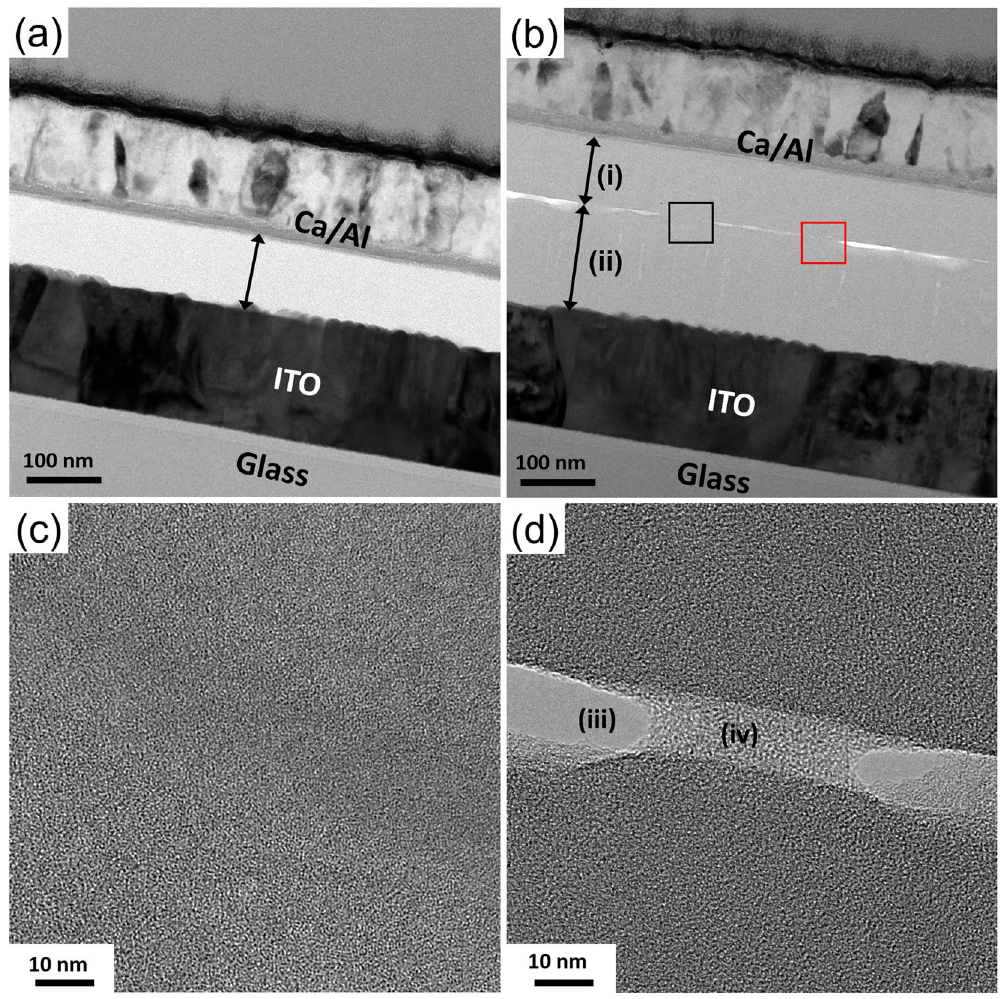
Figure 4. Cross-sectional transmission electron microscope (TEM) images of hybrid organic tandem solar cells. Cross-sectional TEM image of ( a ) spin-coated and ( b–d ) transfer-fabricated tandem solar cells. ( c ) and ( d ) are the images of the regions enclosed by black and red squares in ( b ), respectively. For the transfer-fabricated device, thicknesses of the transferred PCPDTBT:PC 70 BM layer (i) and the thermally evaporated small-molecule layers (ii) were unchanged from the designed values. The features (iii) and (iv) in ( d ) were generated during focused-ion beam milling used in sample